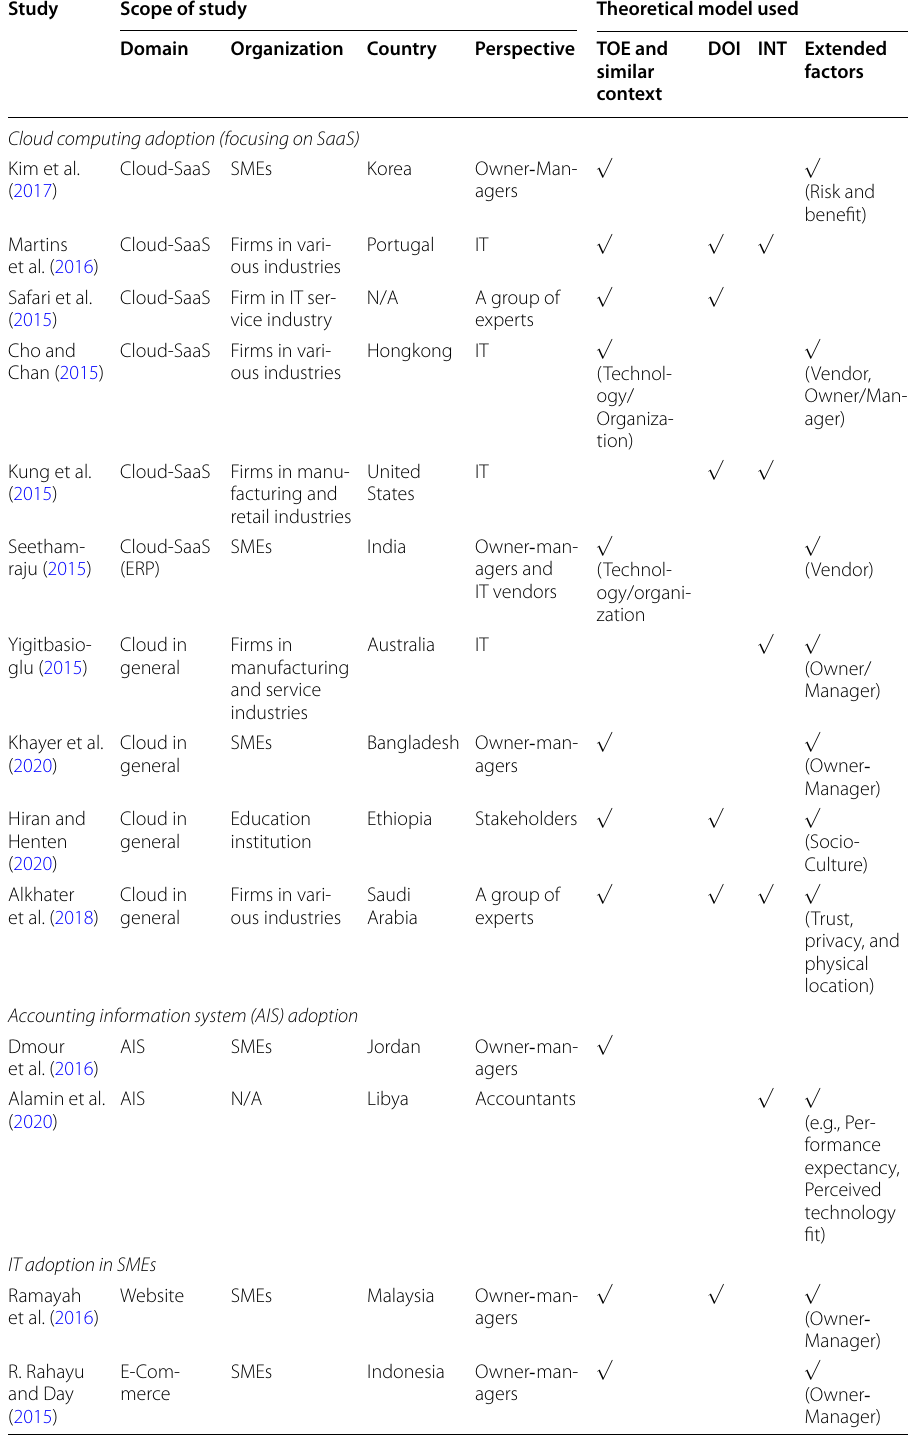
Table 3 Previous studies on adoption of cloud computing, AIS, and IT in